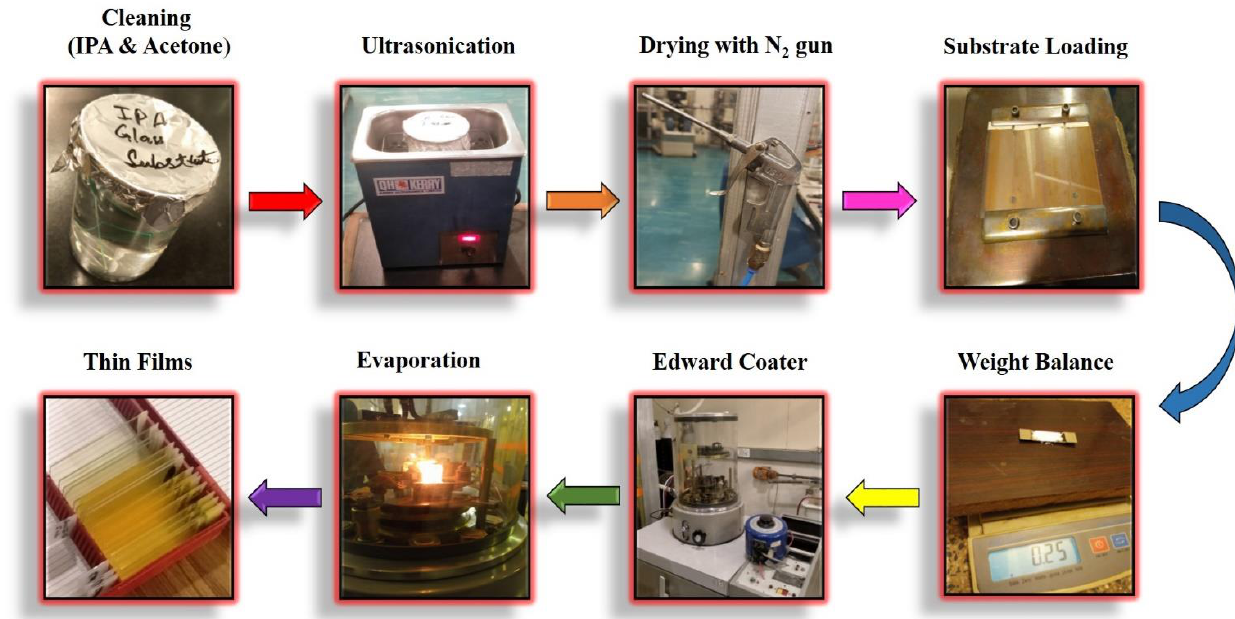
Figure 2. Thin film preparation steps.